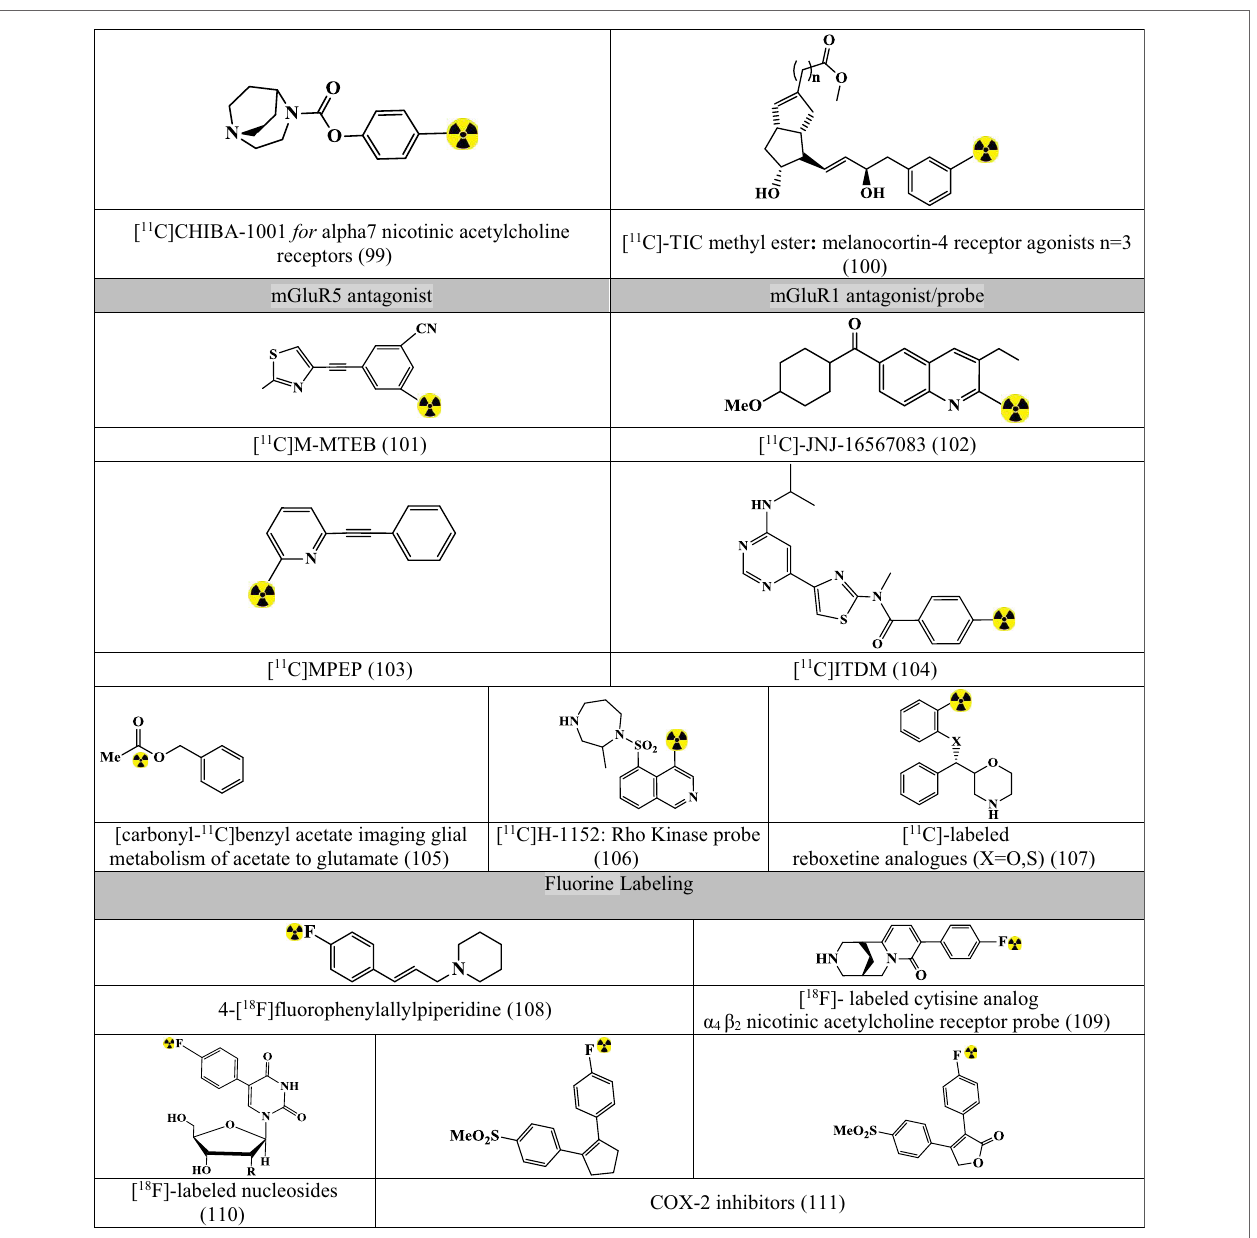
(i) aryl iodide or aryl boranes (reactant) with Pd(PPh 3 ) 4